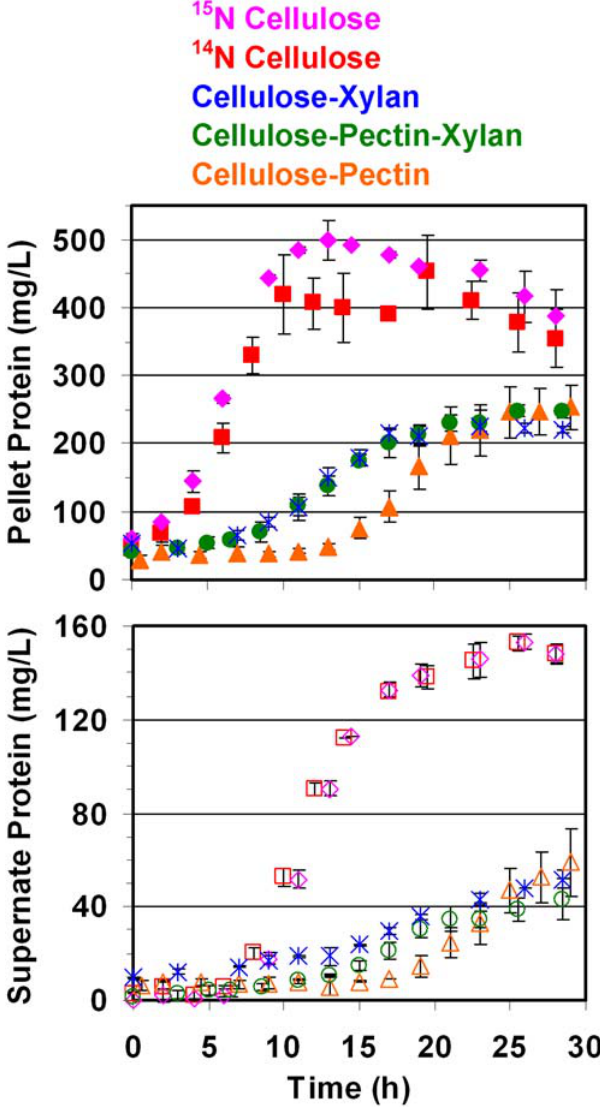
Figure 2. Clostridium thermocellum growth profile on various substrates, based upon protein levels. Pellet protein (top panel) and supernatant protein (bottom panel) profiles of Clostridium thermocellum during growth on various biomass carbohydrates, as estimated by BCA and Bradford protein assays, respectively. Data represented is the average of two biological replicate fermentations of C. thermocellum in minimal medium containing 5 g/L total of the following carbon substrates: Cellulose with 15 N labeled nitrogen source, Cellulose with 14 N labeled nitrogen source, Cellulose-Xylan (3:2 weight ratio), Cellulose-Pectin-Xylan (3:1:1), and Cellulose-Pectin (3:2). Data is not shown for Z-Trim H , pretreated switchgrass and cellobiose